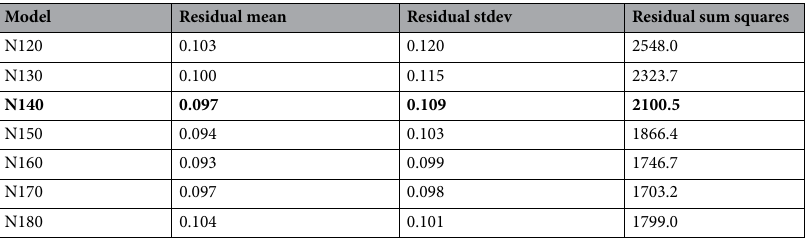
Table 1. List of numerical models with variable σ1 ranging from N120 to N180. Best fit models are for σ1 oriented N160-N170. Selected model with σ1 oriented N140 (in bold) reproducing various structural features of the LRB was selected for this study.